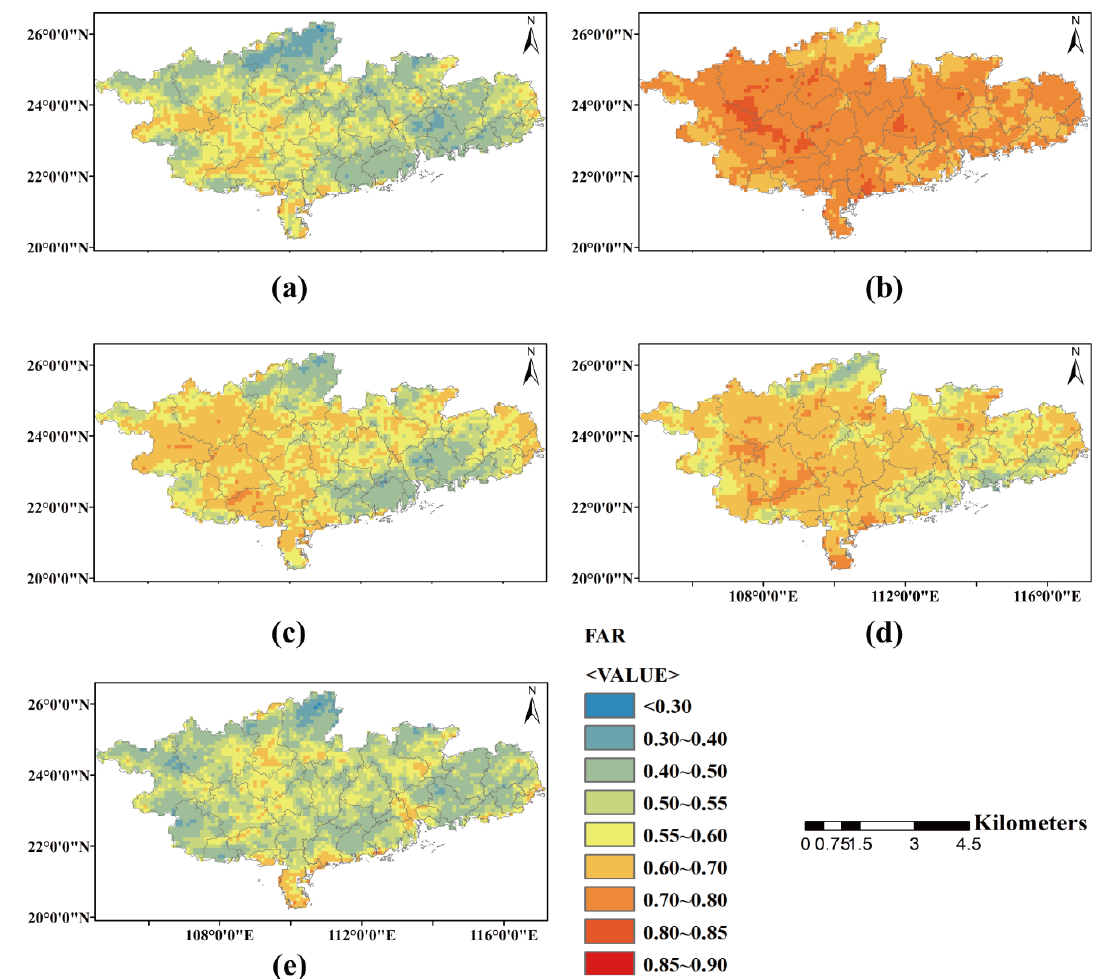
Figure 10. Spatial patterns in terms of false alarm ratio (FAR) based on ( a ) PERSIANN-CCS, ( b ) ERA5-Land, ( c ) FY-4A, ( d ) GSMaP, and ( e ) IMERG against CMPA at hourly scale over southern China in summer 2019.